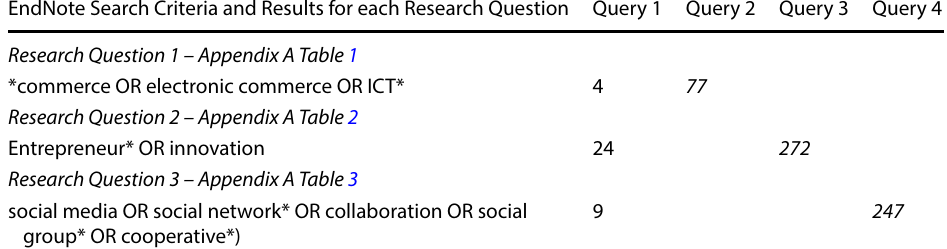
Table 3 Final Selection of Articles for Each Research